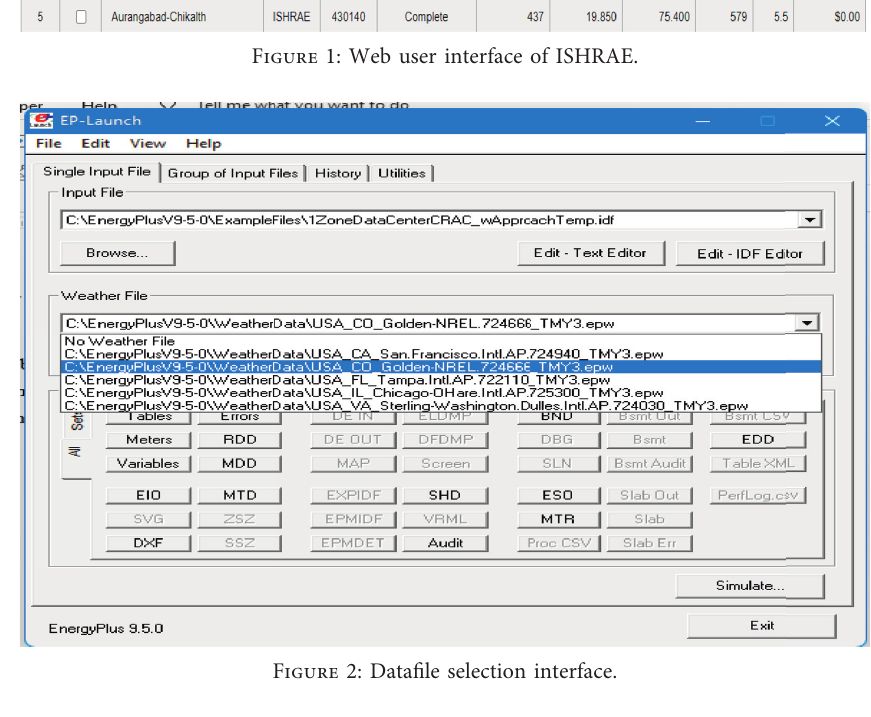
Figure 2: Datafile selection interface.